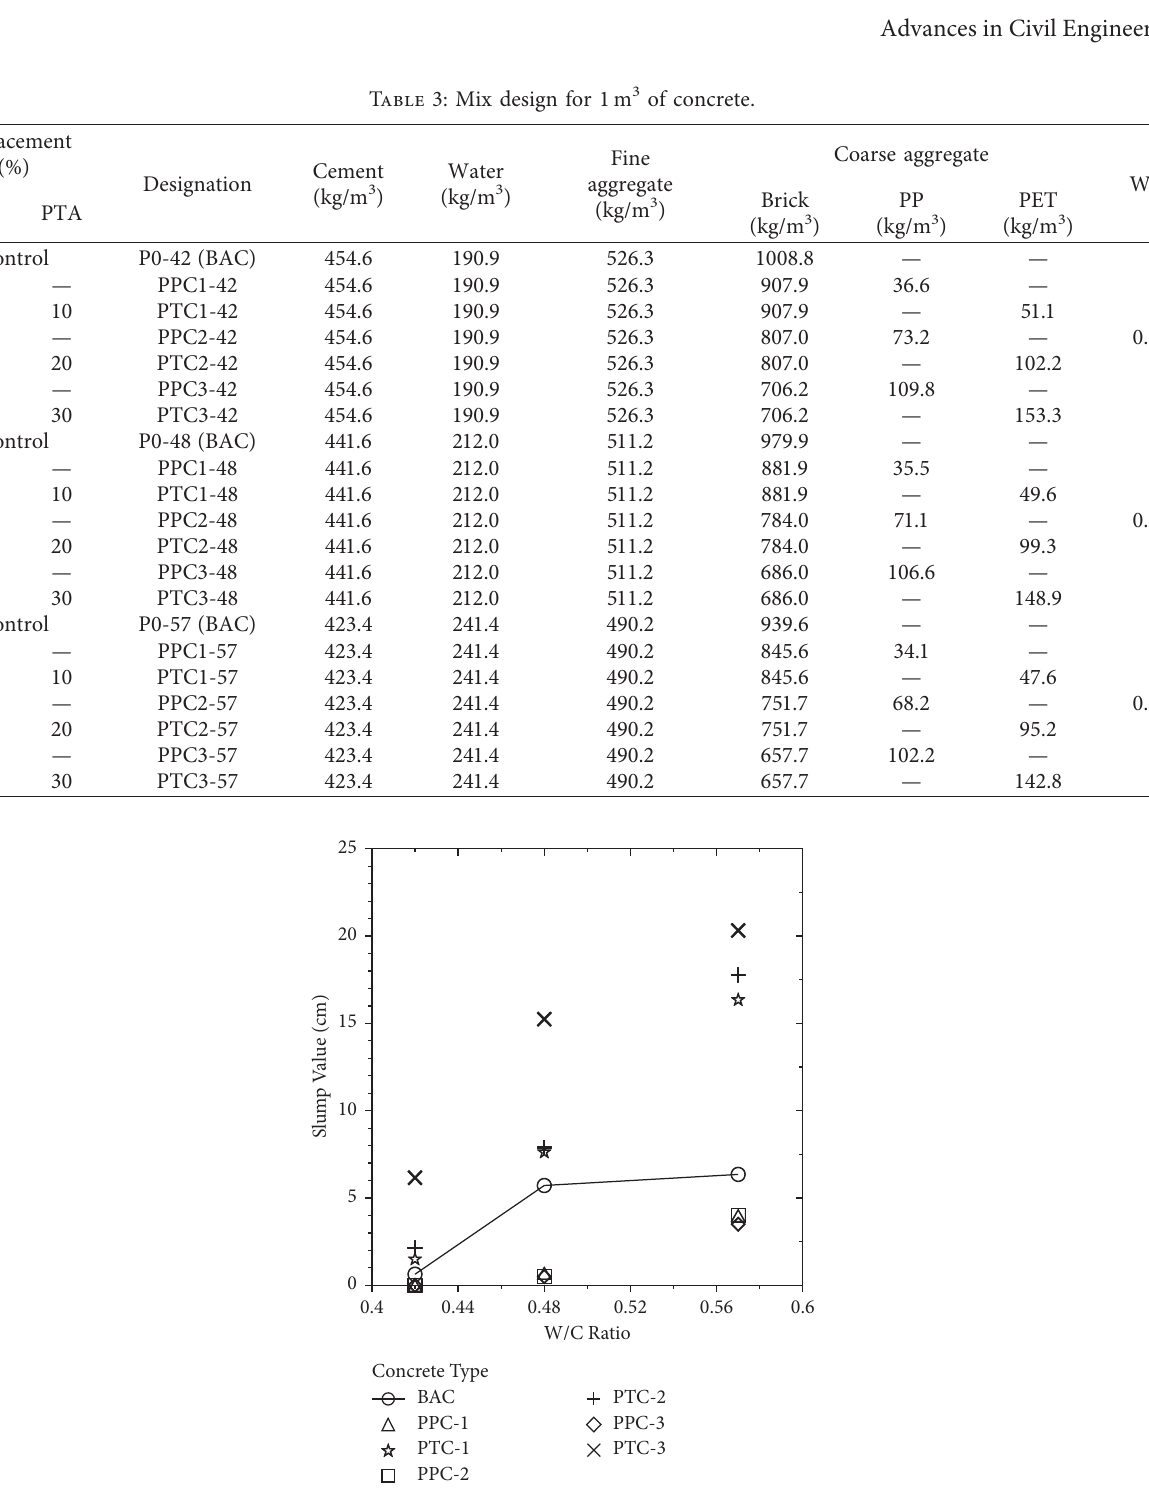
Figure 3: Slump values for various concrete